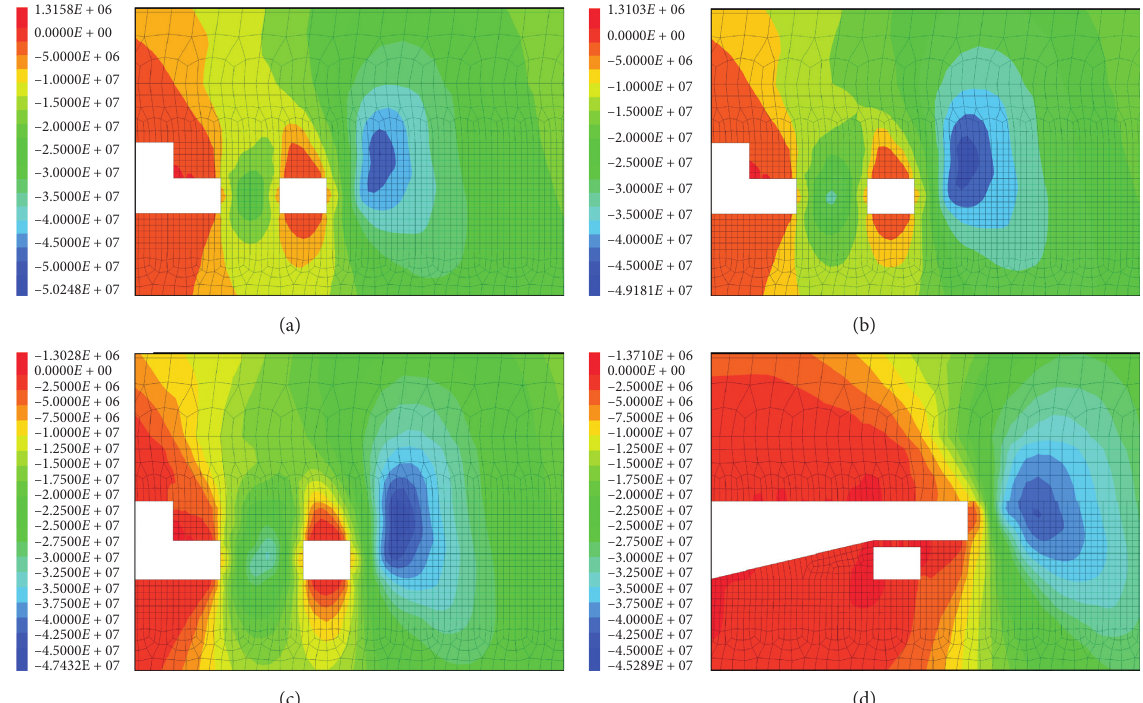
Figure 8: Vertical stress of gob-side entry. (a) 5m. (b) 6 m. (c) 7m. (d) − 8